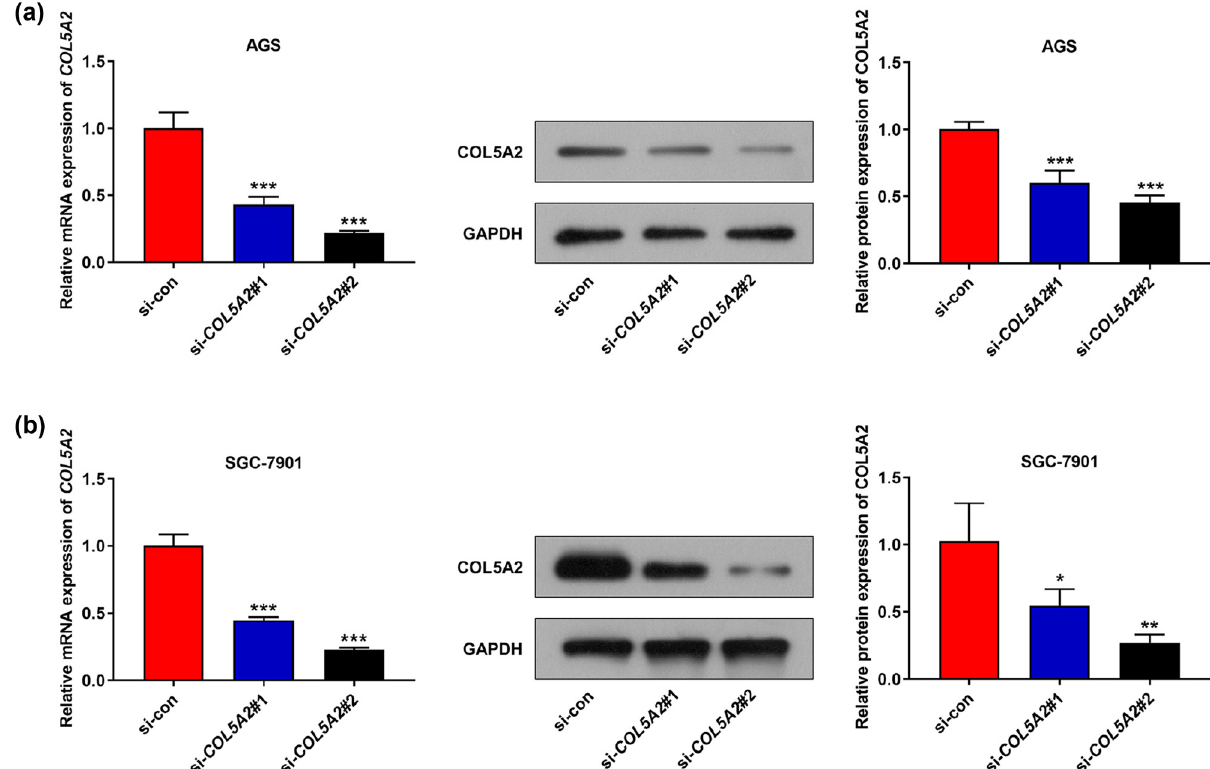
Figure 4: COL5A2 expression was down - regulated in GC cells after transfected with si - COL5A2 . ( a ) mRNA and protein expressions of COL5A2 were analyzed in si - COL5A2 ( si - COL5A2 #1 or si - COL5A2 #2 )- or si - con - transfected AGS cells. ( b ) mRNA and protein expressions of COL5A2 were observed in si - COL5A2 ( si - COL5A2 #1 or si - COL5A2 #2 ) or si - con - transfected SGC - 7901 cells. Data from three independent experiments were expressed as mean ± SD. * P < 0.05, ** P < 0.01 and *** P < 0.001 vs si - con